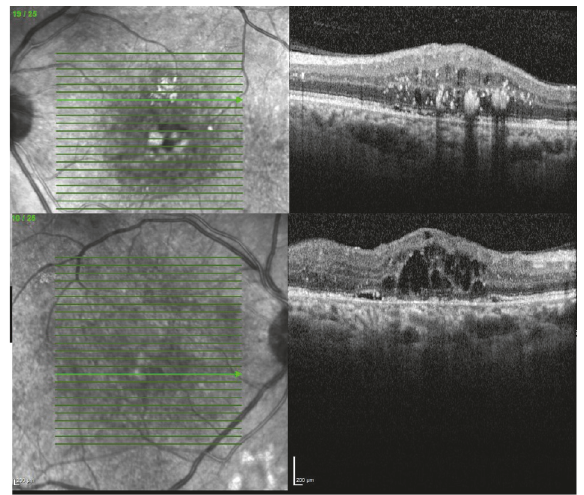
Figure 1: Macular edema secondary to diabetic retinopathy was seen on left eye’s OCT image (superior image). Macular edema secondarytodiabeticretinopathywasseenonrighteye’sOCTimage (inferior image).